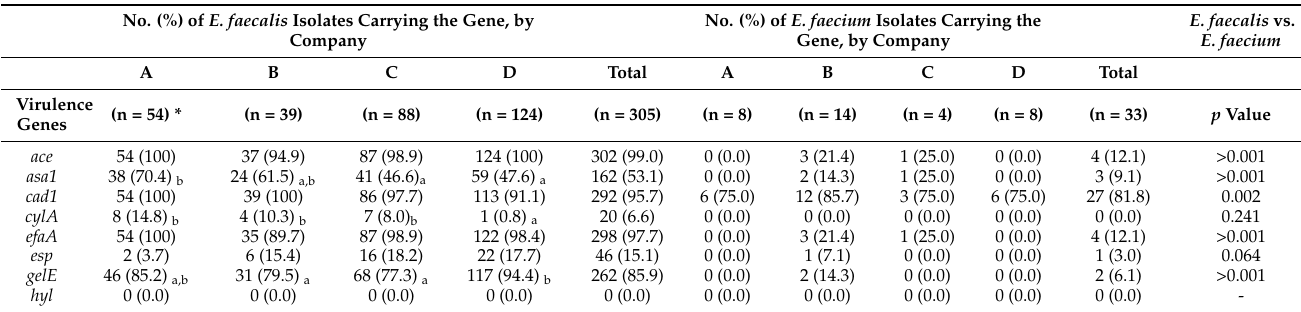
Table 3. Distribution of virulence genes in 305 isolates of Enterococcus faecalis and 33 Enterococcus faecium in bulk tank milk from 4 dairy